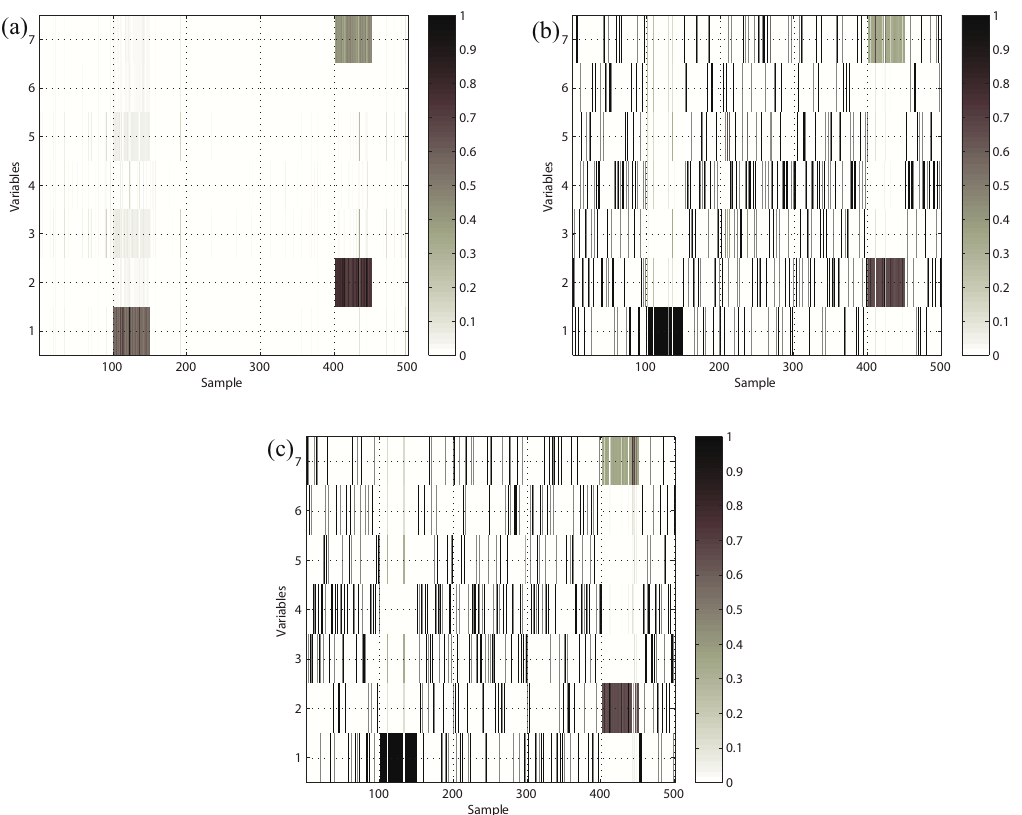
Figure 8. Variable contribution plots. ( a ) k-NN variable contribution, ( b ) PCA-SPE contribution plot, ( c ) RBC method.